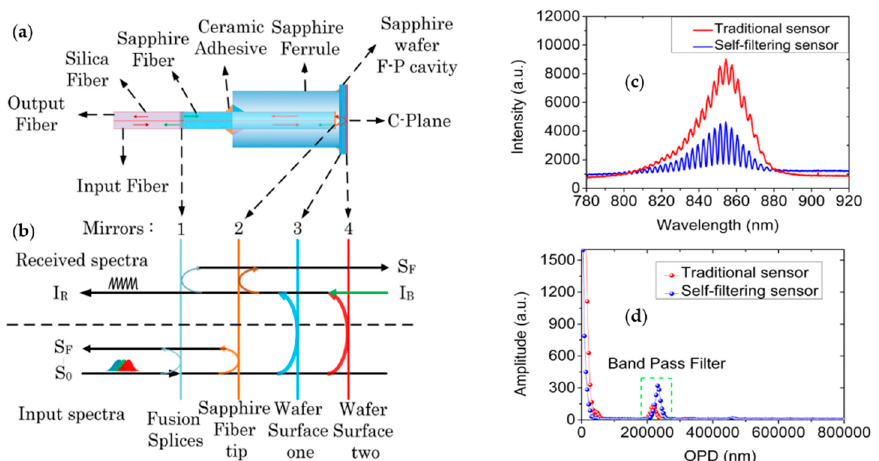
Figure 10. The schematic diagram and the test results of self-filtering sensor. (Reprinted with permission from Ref. [120].) ( a ) Schematic of self-filtering sensor; ( b ) Optical transmission path of self-filtering sensor; ( c ) Interference spectra of a conventional sensor and the self-filtering sensor at 1000 °C; ( d ) Frequency domain spectrum of the two sensors.